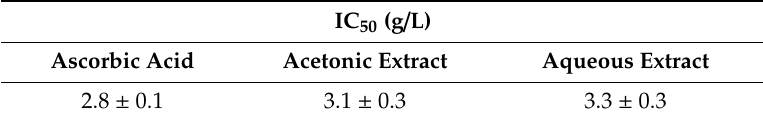
Figure 1. Antioxidant capacity, total phenolic acid, and flavonoid contents from A. borbonica extracts. ( A ) Total antioxidant capacity of polyphenols-rich extracts from A. borbonica was measured by a the 2,2-Diphenyl-1-picrylhydrazyl (DPPH) assay. Ascorbic acid was used as a positive control. The results are expressed as the % of reduced DPPH. ( B ) Total phenolic contents of acetonic and aqueous extracts from A. borbonica were determined using the Folin–Ciocalteu colorimetric assay at a concentration of 40 g / L (plant dried powder). The results are expressed as the mg gallic acid equivalent (GAE) / 100 g of plant dried powder. ( C ) Total flavonoid contents were determined using an aluminum chloride colorimetric assay. The results are expressed as the mg quercetin equivalent (QE) / 100 g of plant dried powder. Data are the means ± SDs of three independent experiments. * p < 0.05, *** p < 0.001 (vs. 40 g / L of acetonic extract), and $$ p < 0.01 (vs. 40 g / L (GAE) ascorbic acid). Table 1. Antioxidant activities of polyphenols-rich extracts from A. borbonica were measured by DPPH assay. Ascorbic acid was used as a positive control. The IC 50 values were obtained by plotting the percentage of free radical-quenching activity against the logarithm of the di ff erent concentrations, ranging from 40 to 2.3 g / L (plant dried powder) for aqueous and acetonic extracts. The results were expressed in g / L. Data are the mean ± SD of three independent